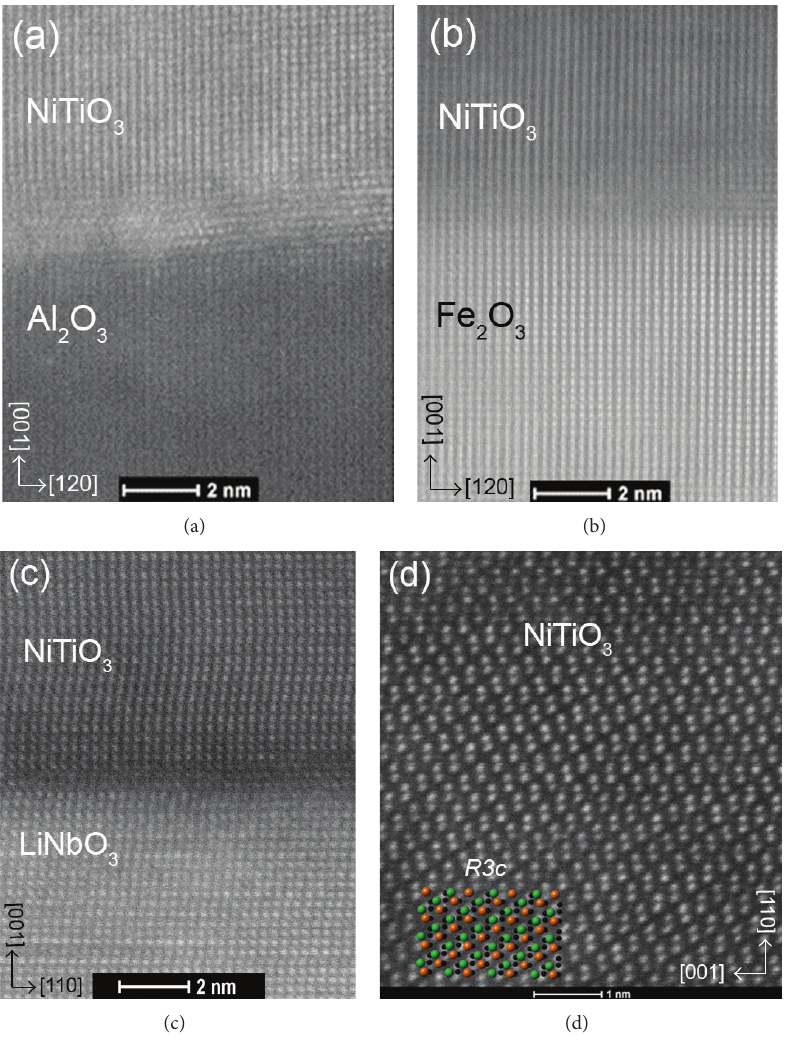
Figure 3: High magnification HAADF-STEM images of the (a) NiTiO 3 /Al 2 O 3 , (b) NiTiO 3 /Fe 2 O 3 , and (c) NiTiO 3 /LiNbO 3 interface. (d) Comparison of a high-resolution STEM image of NiTiO 3 grown on Al 2 O 3 with an overlay of its theoretical LNO-type structure (space group R3c